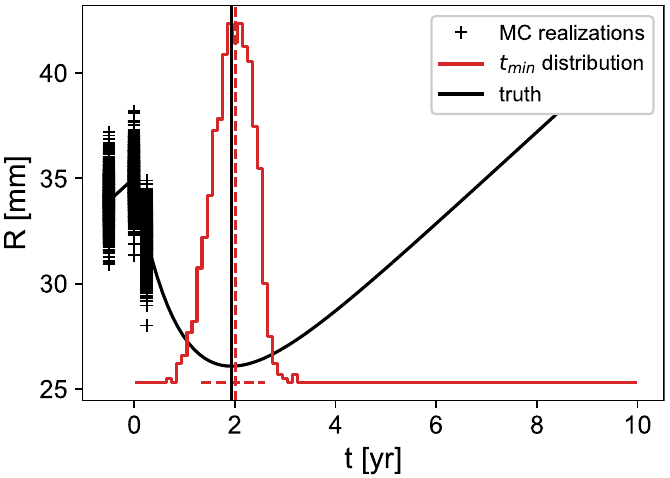
Fig 6. Characterization of there growth time estimation with a Monte-Carlo method. The black curve represents a model (which is here the bestfit of patient (18)) with its minimum shown as the vertical black line (“truth”). One draws some Gaussian noise of σ = 1 mm at the measurement times t mes = [ − 6, 0, 3] months, and performs the t described in the text. This is repeated 1000 times which allows to construct the red histogram of all the t min estimates. The red vertical dashed line shows its mean value and the horizontal one the [0.05,0.95] percentile region.